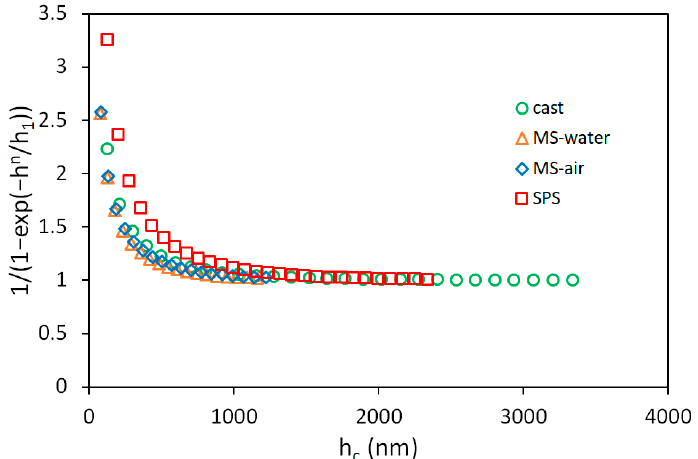
Figure 8. Expansion of effective plastic zone volume of CoCrFeMnNi samples.